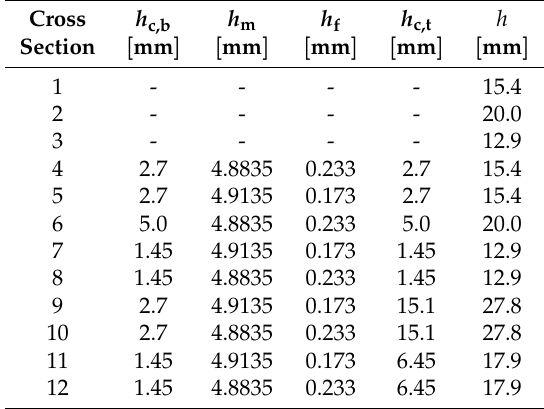
Figure 21. Cross section with a resolved layer of fabrics and with strain-softening layers σ 3300 σ 3300 + 800 and strain-softening layers σ m for add-on plain concrete layers. f Table 3. Cross section layups corresponding to the curve (iv) in Figure 21.